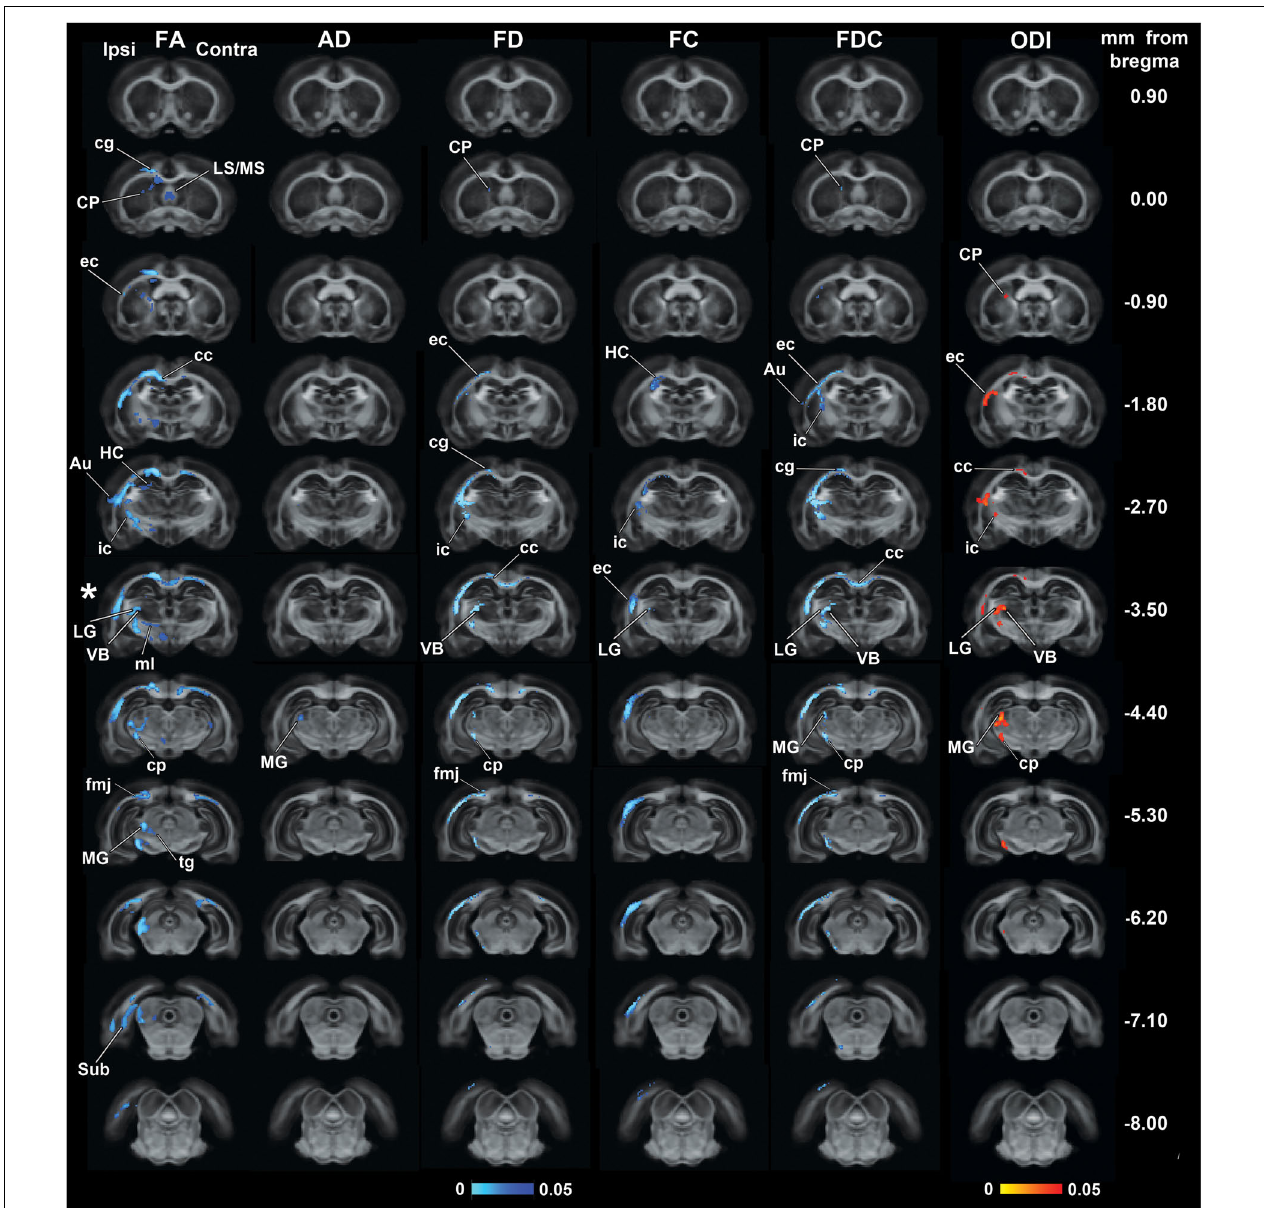
FIGURE 1 | Whole-brain group differences in FA, AD, FD, FC, FDC, and ODI metrics when comparing sham-operated and mTBI rats after 35 days of the sham-operation or injury. Areas displaying significant group differences in mTBI versus sham-operated rats (TFCE, p -value < 0.05, FWE-corrected) are overlaid on the FOD-based template. Significances are displayed as voxels in a light-dark blue scale, representing mTBI group values lower than sham-operated group values, and in a red-yellow scale, representing mTBI group values higher than sham-operated group values. The asterisk shows the epicenter of the lesion. Au, auditory cortex; cc, corpus callosum; cg, cingulum; cp, cerebral peduncle; CP, caudate putamen; ec, external capsule; fmj, forceps minor of the corpus callosum; HC, hippocampus; ic, internal capsule; LG, lateral geniculate nuclei; LS/MS, lateral/medial septal nucleus; MG, medial geniculate nucleus; ml, medial lemniscus; Sub, subiculum; tg, tegmental nuclei; VB, ventrobasal